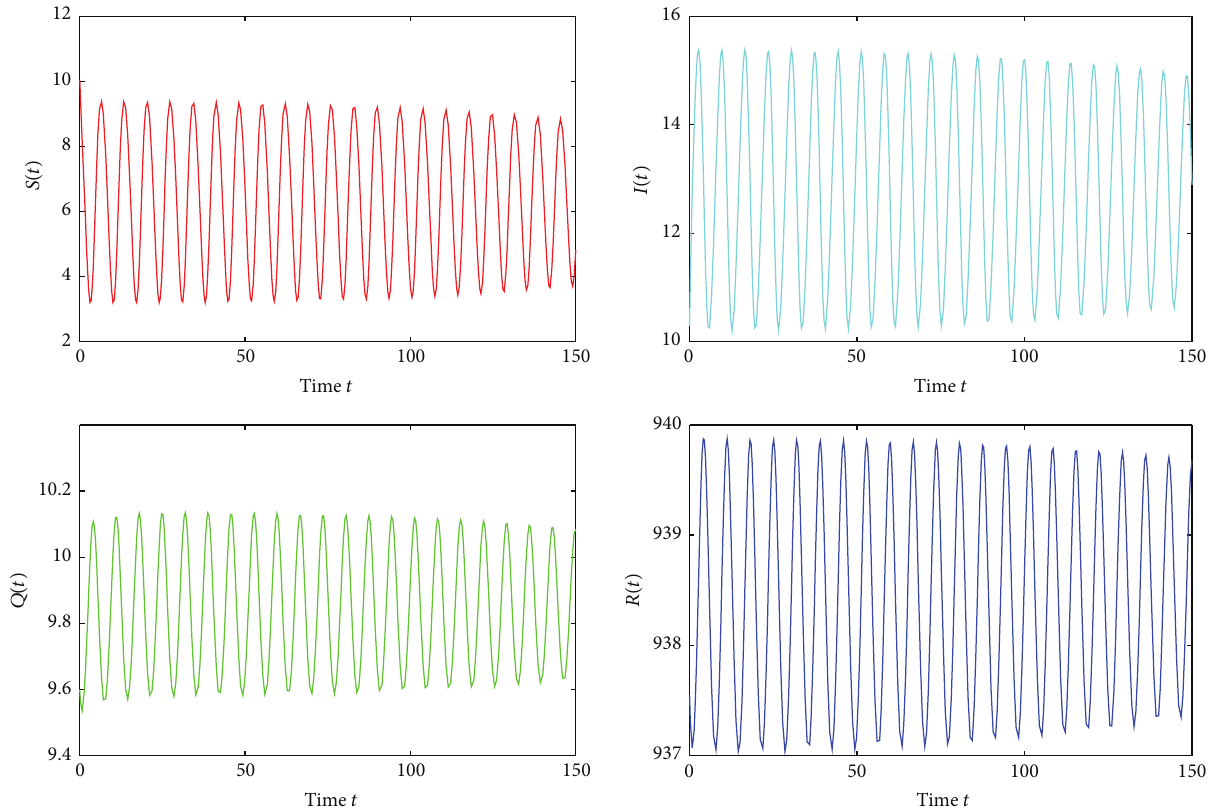
Figure 4: The track of the states 𝑆 , 𝐼 , 𝑄 , and 𝑅 for 𝜏 = 1.3625 > 1.3265 = 𝜏 0